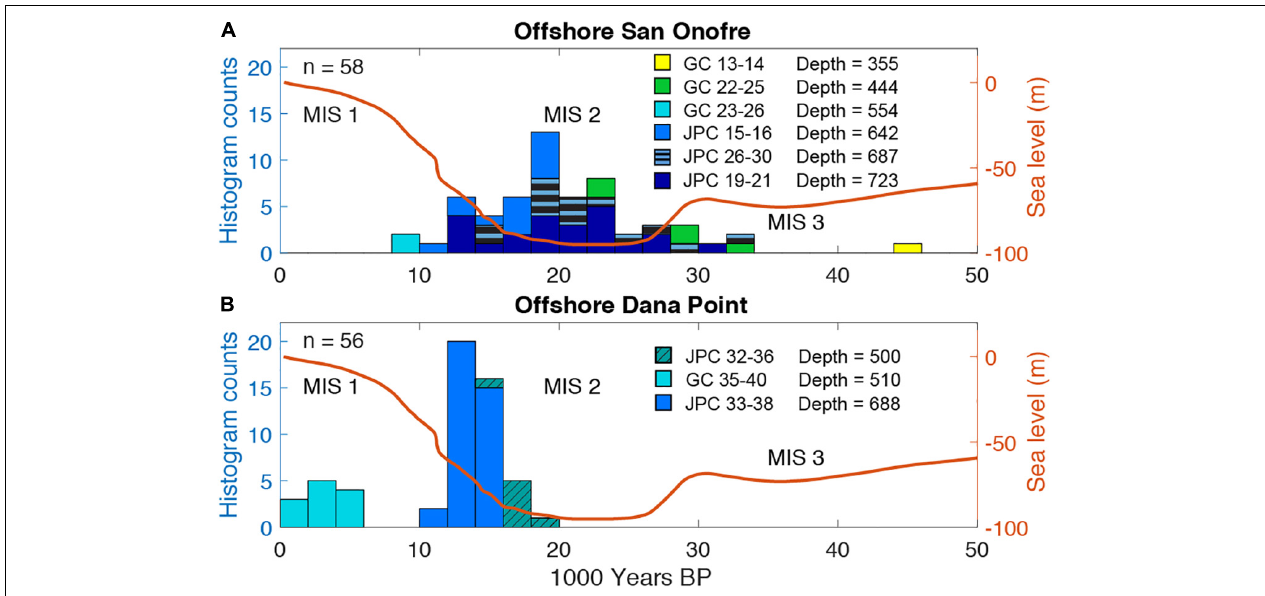
FIGURE 11 | (A) Histograms of sand layer depositional timing offshore San Onofre and Dana Point have bins of 2000 years. (A) The number of sand layers recovered from cores offshore San Onofre. (B) The number of sand layers recovered from cores offshore Dana Point. In orange, the Southern California sea-level curve from Muhs et al. (2012) versus